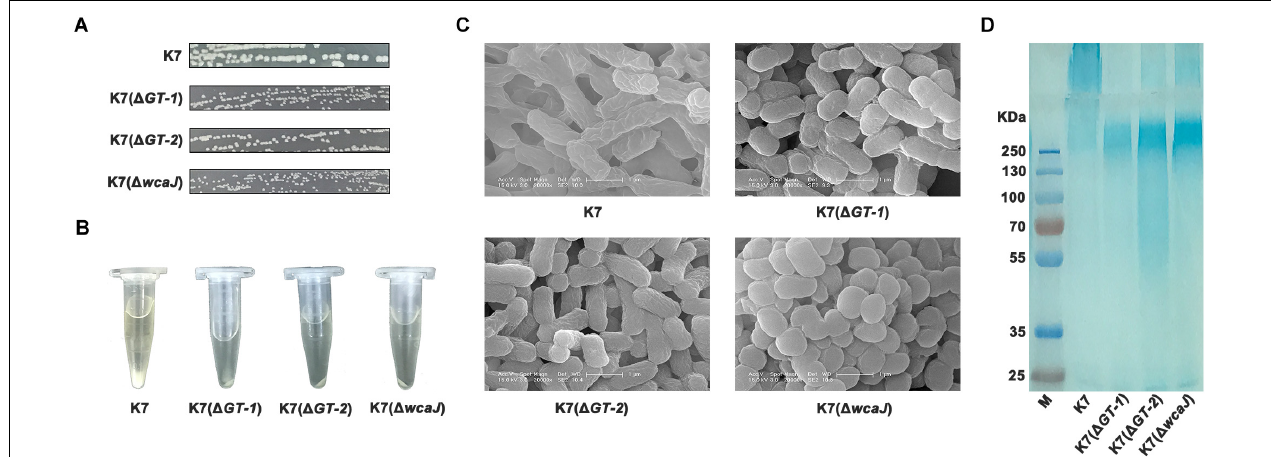
FIGURE 4 | Characteristics of K. pneumoniae K7( (cid:49) GT-1 ), K7( (cid:49) GT-2 ), and K7( (cid:49) wcaJ ). (A) Colony morphologies of K. pneumoniae K7( (cid:49) GT-1 ), K7( (cid:49) GT-2 ), and K7( (cid:49) wcaJ ). Colonies of K7( (cid:49) GT-1 ), K7( (cid:49) GT-2 ), and K7( (cid:49) wcaJ ) were cultured on LB plates at 37 ◦ C for 12 h after streak plating. The three mutant strains all form rough-type colonies. K7 was used as a control. (B) Centrifugation analysis of K. pneumoniae K7( (cid:49) GT-1 ), K7( (cid:49) GT-2 ), and K7( (cid:49) wcaJ ). The cultures were centrifuged at 10,000 × g for 5 min. K7 was used as a control. (C) SEM analyses of the surface morphology of K. pneumoniae K7( (cid:49) GT-1 ), K7( (cid:49) GT-2 ), and K7( (cid:49) wcaJ ). Scale bars represent 1 µ m. K7 was used as a control. (D) CPS samples were extracted from equal amounts of K. pneumoniae strains (1.0 × 10 9 CFU). After separated by 12% SDS-PAGE, CPS phenotypes of K7( (cid:49) GT-1 ), K7( (cid:49) GT-2 ), and K7( (cid:49) wcaJ ) were visualized by alcian blue staining. CPS of K7 was used as a